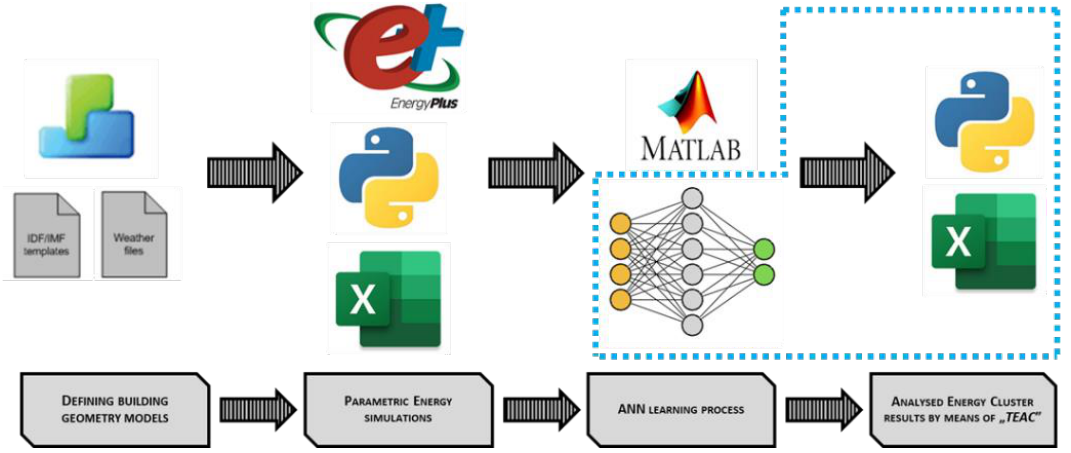
Figure 2. The schematic concept of the TEAC software. The procedure is developed for the Representative Single-Family Houses (RSFH) of Poland, and those seven buildings were defined by means of the Design Builder software